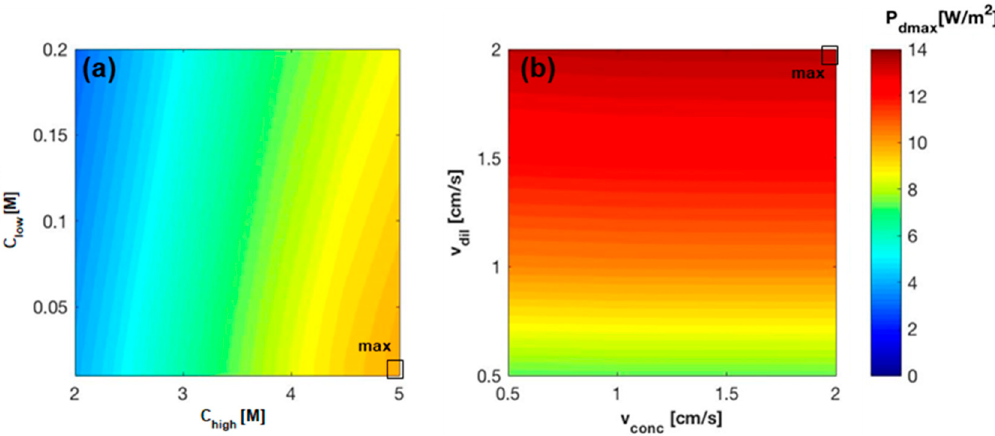
Figure 9. Dependence of power density on ( a ) feeds inlet concentration with fixed inlet solutions velocity ( v L = v H = 1 cm/s); ( b ) feeds inlet velocity with fixed inlet solutions concentration ( C L = 0.05 M and C H = 4.5 M). RED stack of 50 cp, with a membrane area of 0.1 × 0.88 m 2 , counter-current arrangement, ideal membranes.